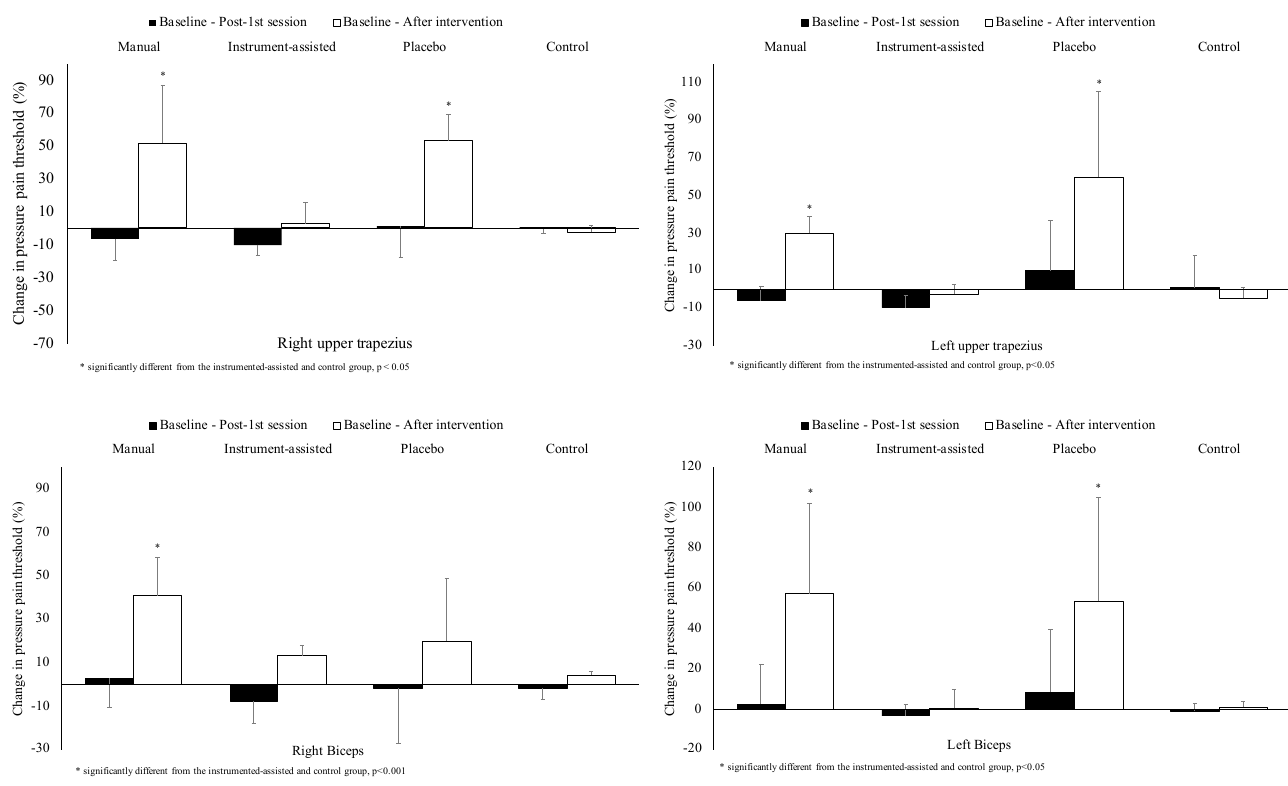
* significantlydifferent from the instrumented-assisted and control group, p<0.05 Figure 3. Immediate (baseline—post 1st session) and mid-term (baseline—after intervention) effects of the interventions in pressure pain threshold.